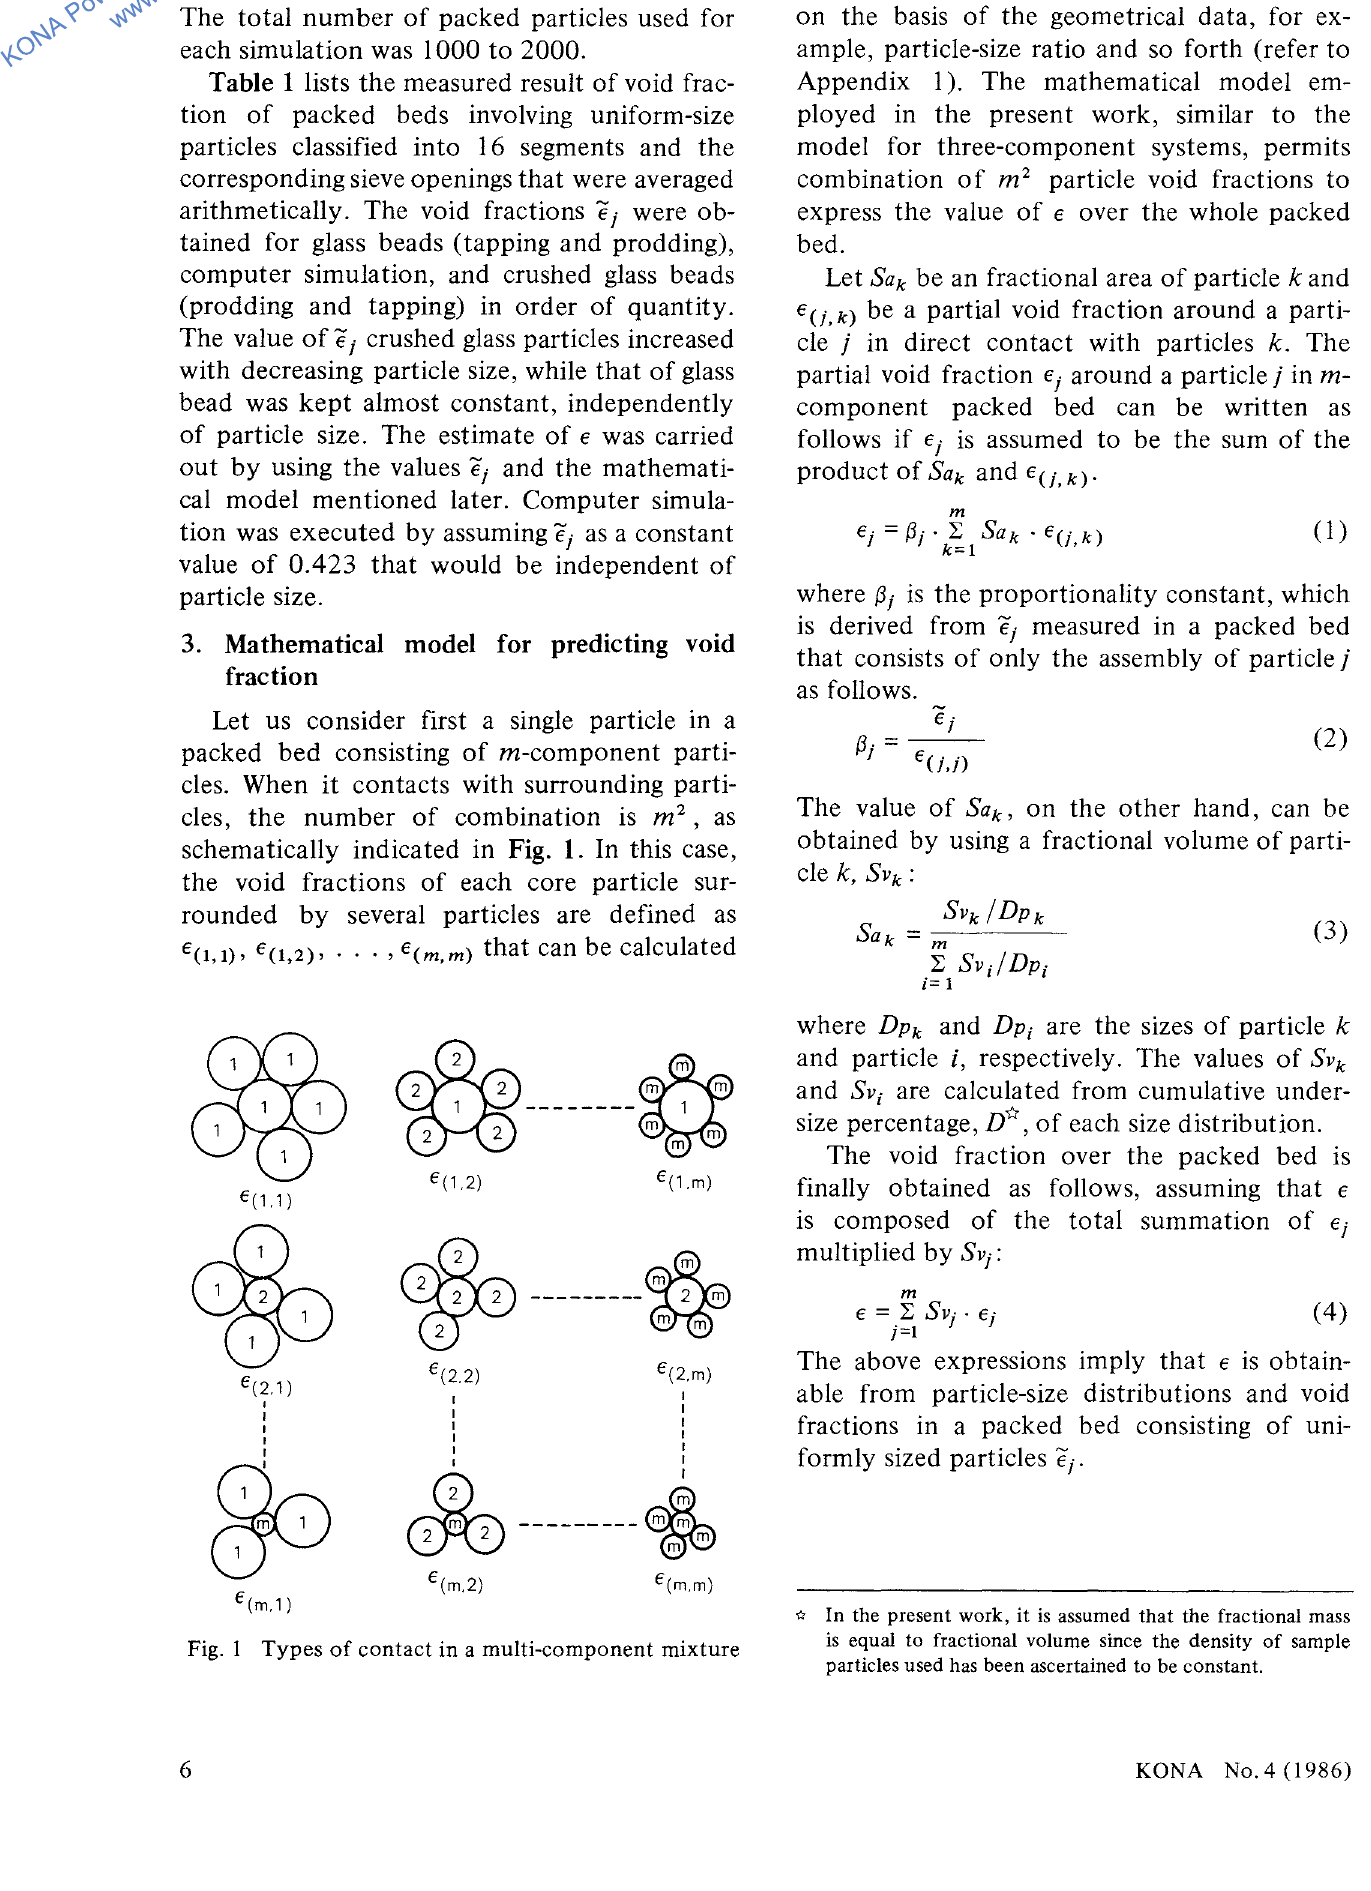
Fig. 1 Types of contact in a multi-component